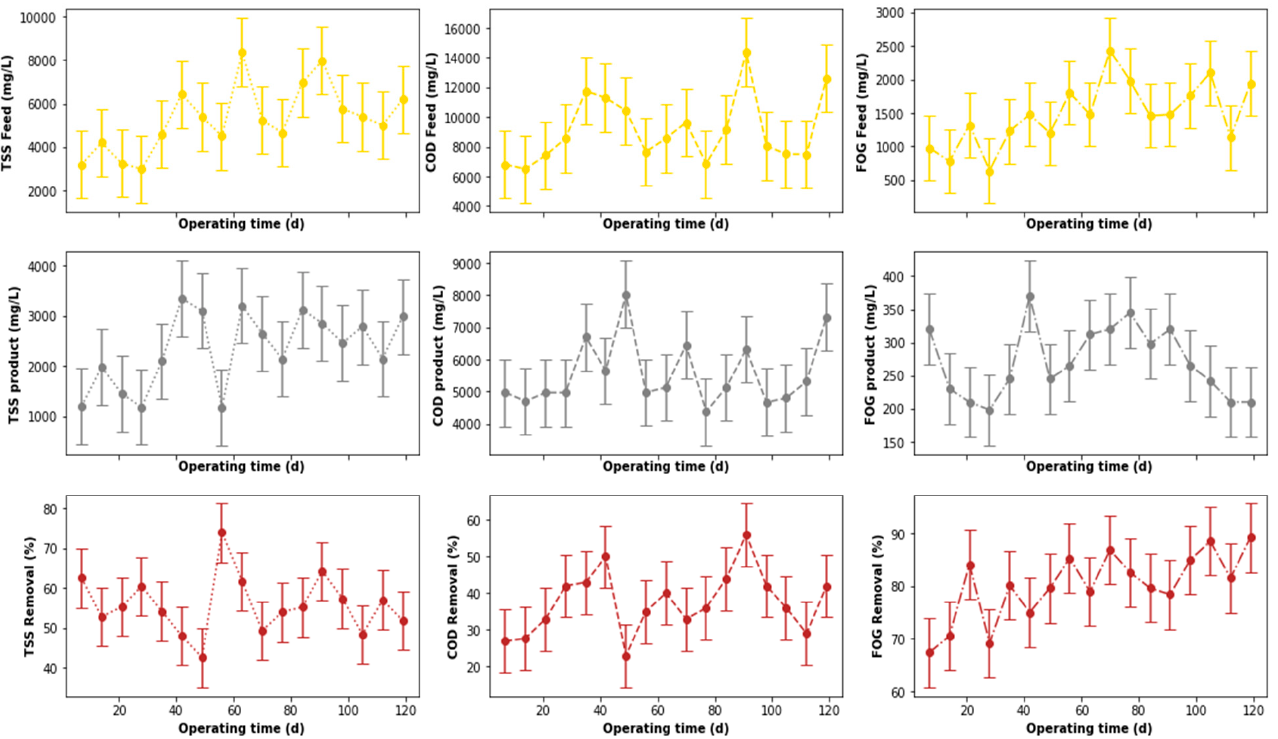
Figure 9. Performance of PSW pre-treatment stage after outliers’ detection and replacement.